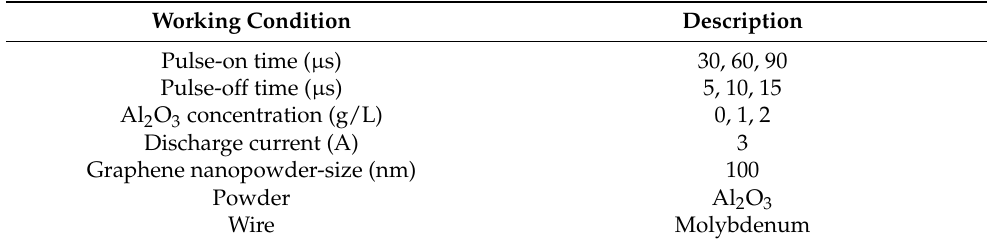
Table 1. Experimental conditions of PMWEDM operation. Working Condition Description Pulse-on time ( µ s) 30, 60, 90